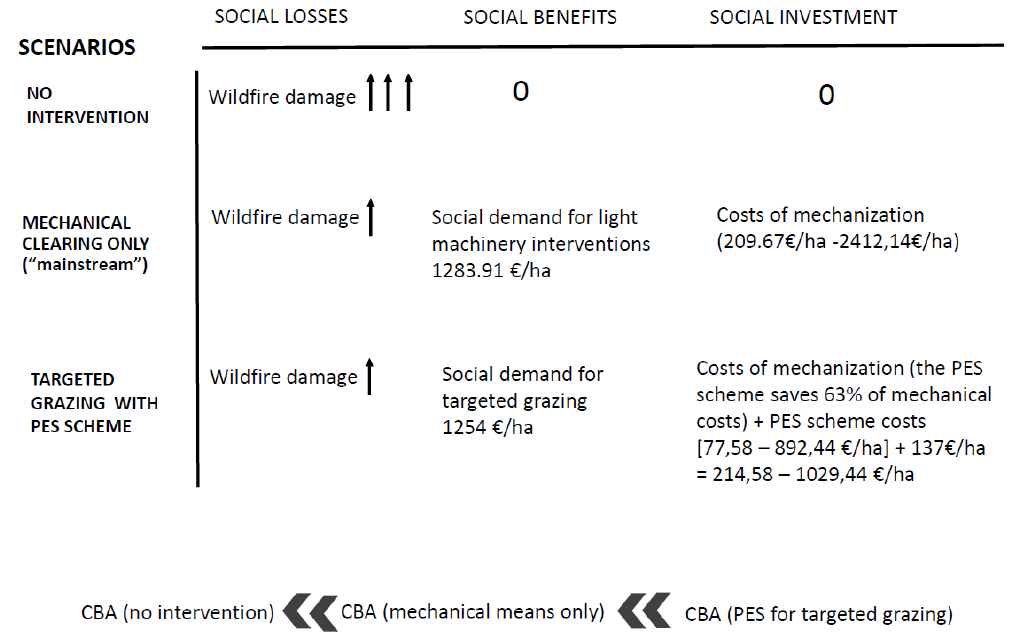
Figure 1. Land manager benefits and social costs in three scenarios: with no fire prevention, fire prevention with targeted grazing, and targeted grazing remunerated service. Source: own elaboration based on Engel et al. [93].